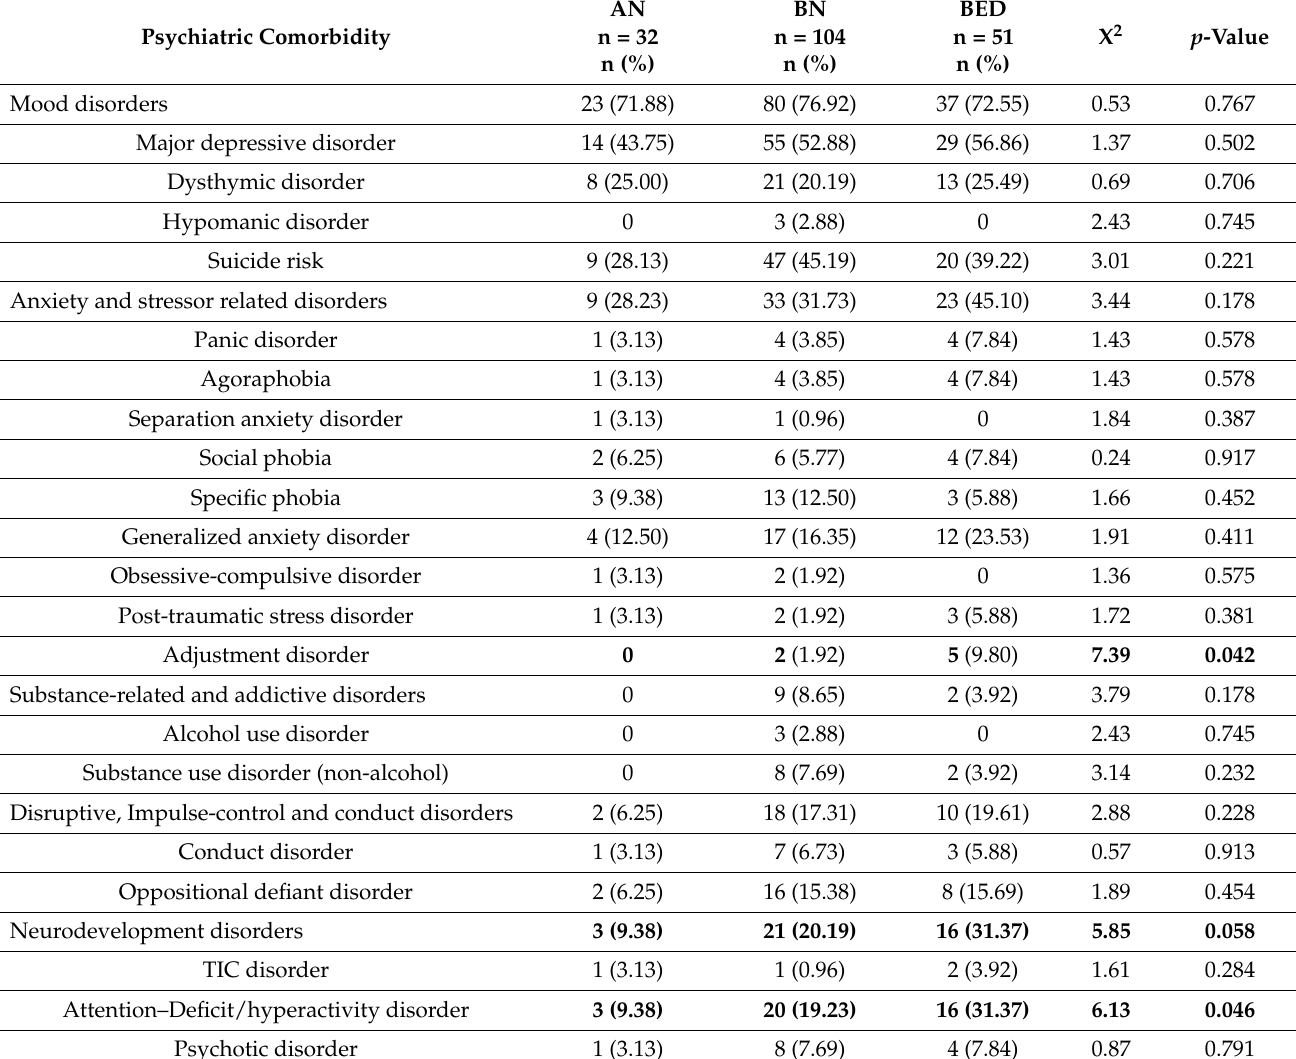
Table 2. Comparison of psychiatric comorbidities in Mexican patients with eating